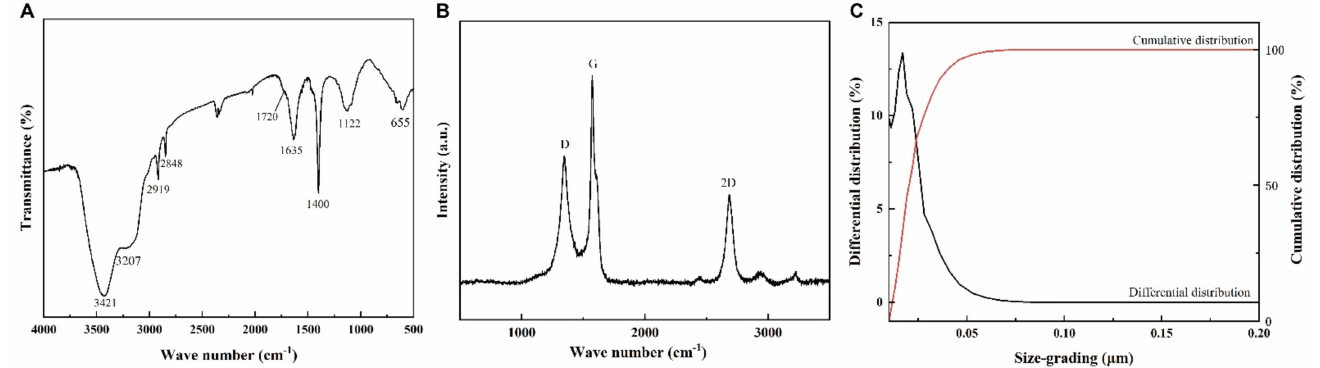
Figure 2. Characterizations of the surface morphology of graphene. ( A , B ) SEM images of graphene and ( C , D ) TEM images of graphene.